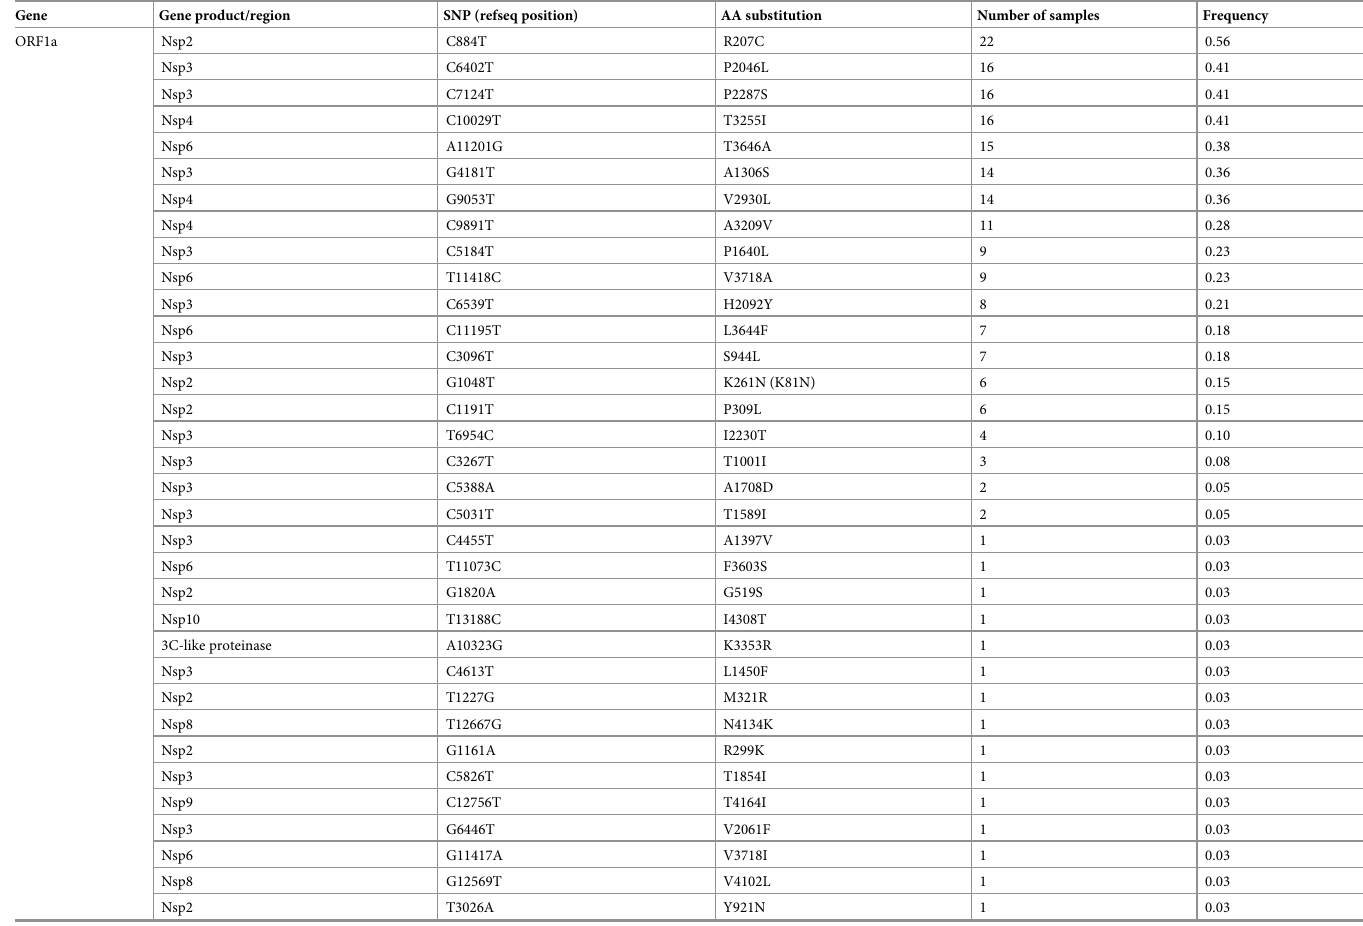
Table 4. The frequency of missense mutation in the SARS-CoV-2 genotypes identified in Uzbekistan (nucleotide and amino acid positions are indicated relative to the reference genome NC_045512.2).